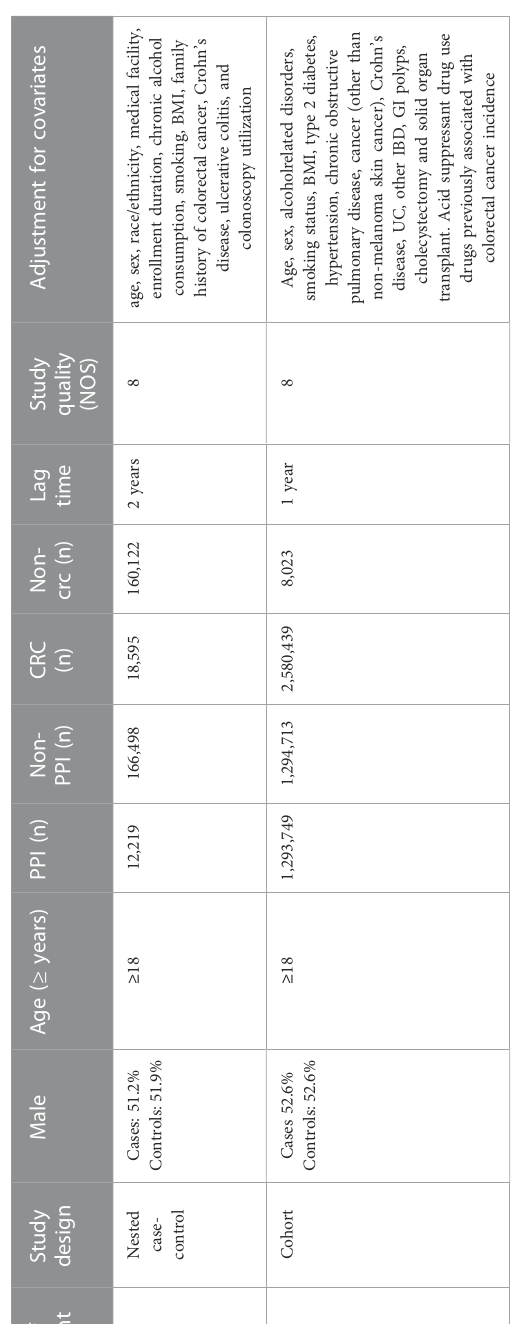
95% CI: 1.28 – 2.37; > 3 years RR = 2.32, 95% CI: 1.15 – 4.66) (Figure 4). PPI use was still positively associated with gastric cancer risk after eradication of potential confounders of H. pylori infection (RR = 3.09, 95% CI: 2.74 – 3.49) (Figure 5). Subgroup